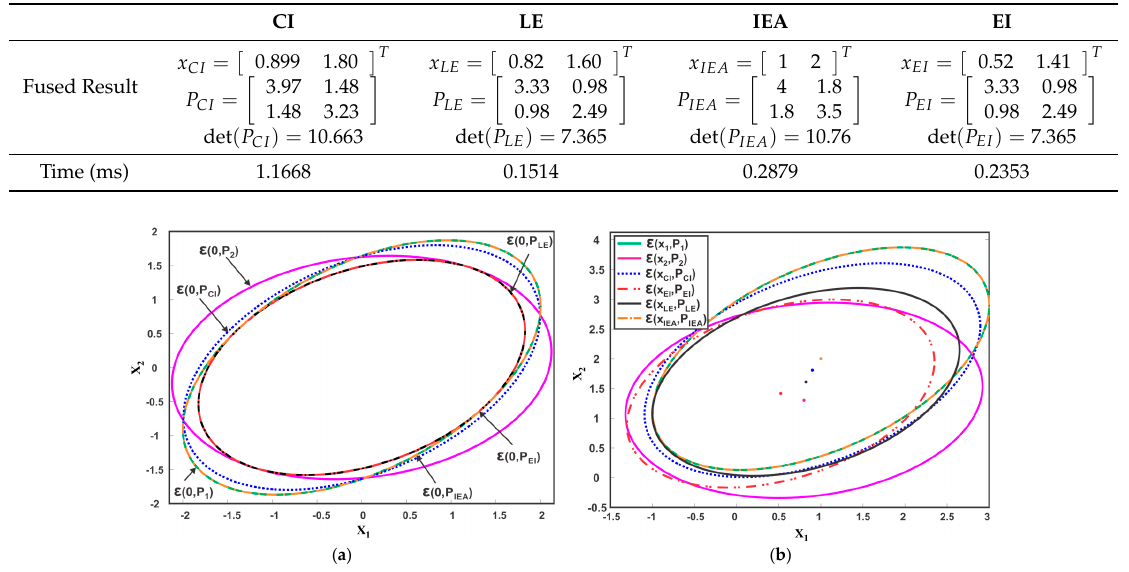
Table 1. Fused result and average computation time of different ellipsoidal methods.